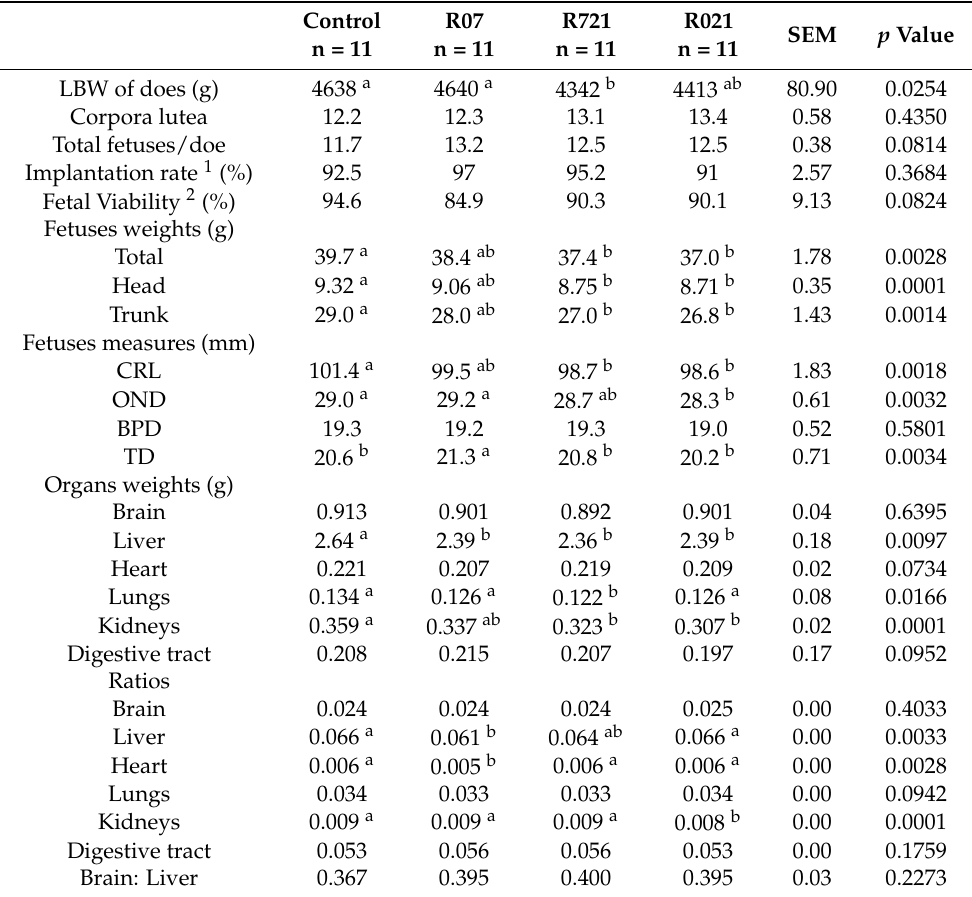
Table 1. Number and biometric parameters of fetuses of 28 days of gestational age in rabbits fed ad libitum (Control), restricted to 60% one week from day 0 to 7 (R07), two weeks from day 7 to 21 (R721) and three weeks from day 0 to 21 (R021) of gestation.